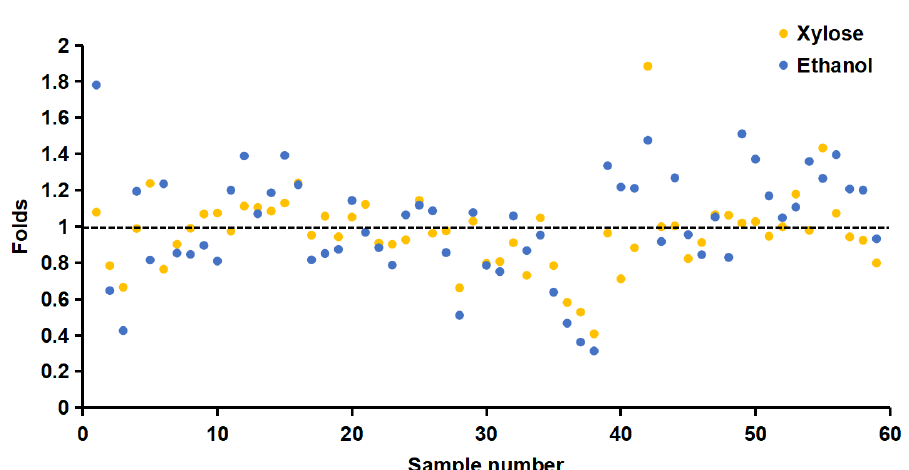
Figure 2. Amino acid sequence alignment of xylosidase Xyl21 and the xylosidases from Dictyoglomus thermophilum (Xln-DT), Geobacillus thermodenitrificans NG80-2 (Xyn-B1), high temperature horse ma- nure compost (XylP81), and Geobacillus sp. (WSUCF1). The same amino acids are marked with a red or light red background. The α - helix and β -sheet secondary structures of Xyl21 are labeled above. The two catalytic glutamic acid residues E160 and E278 are marked by green boxes, and the three mutated sites K16, L94, and K262 were labeled with black boxes.